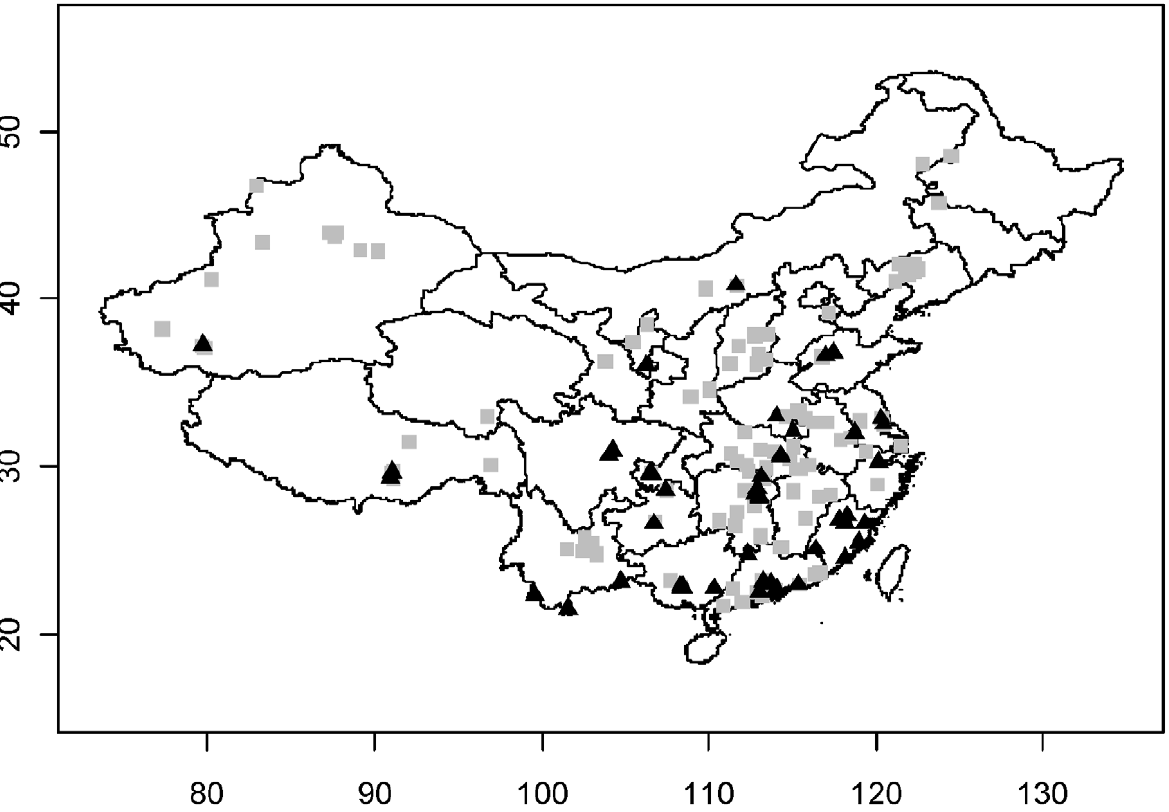
Figure 1. Distribution of HPAI H5N1 outbreaks (grey square) and HPAI H5N1 positive samples identified through surveillance (black triangles) in China.